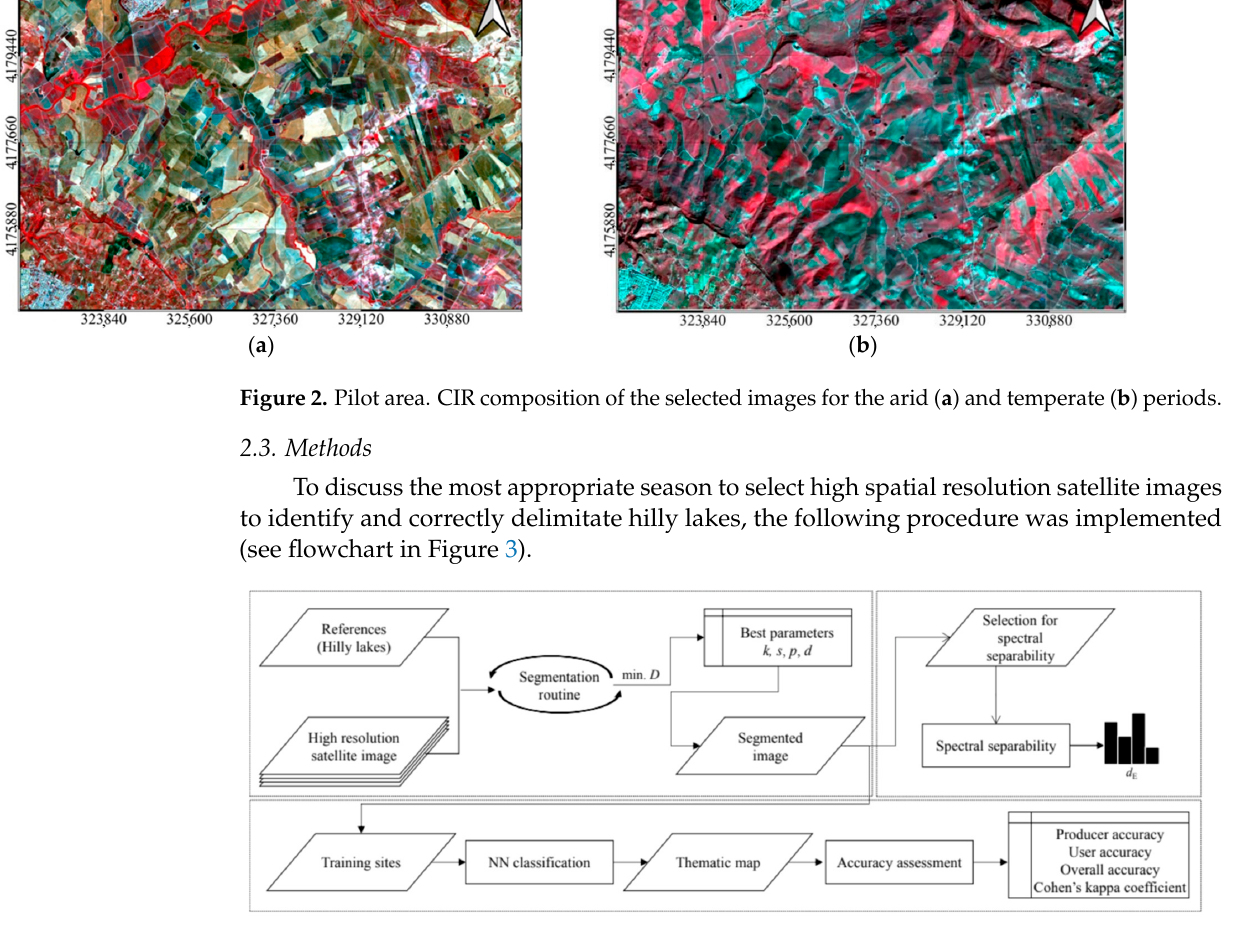
Figure 3. Flowchart of the procedure to test the proposed method.